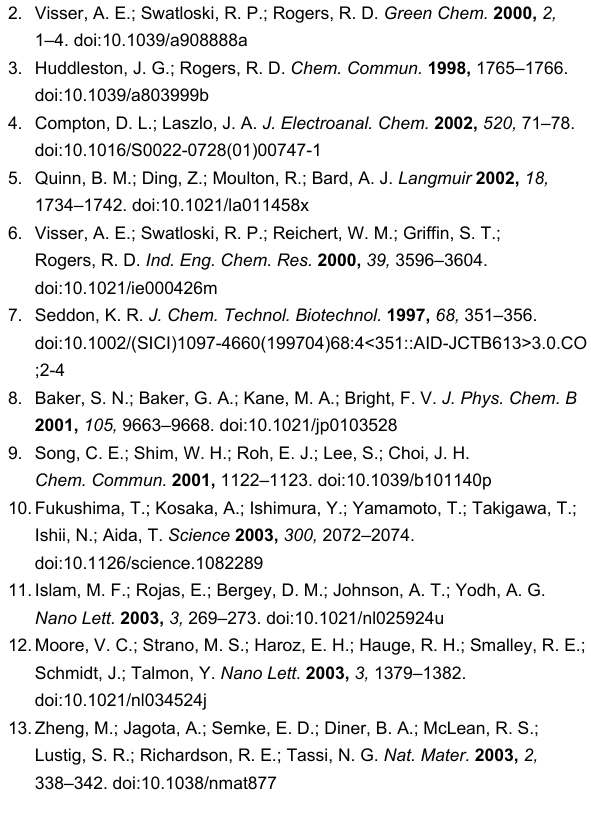
Figure 6: Absorption spectra of [BMIM] + [BF 4 ] − -dispersed SWNTs without treatment (black curve), after subtraction of water spectrum (blue curve), and treated under vacuum for 10 hours (red curve). The spectra are offset arbitrarily in the vertical direction for clarity. The inset shows the partially enlarged spectra. Arrows indicate the positions of water bands.